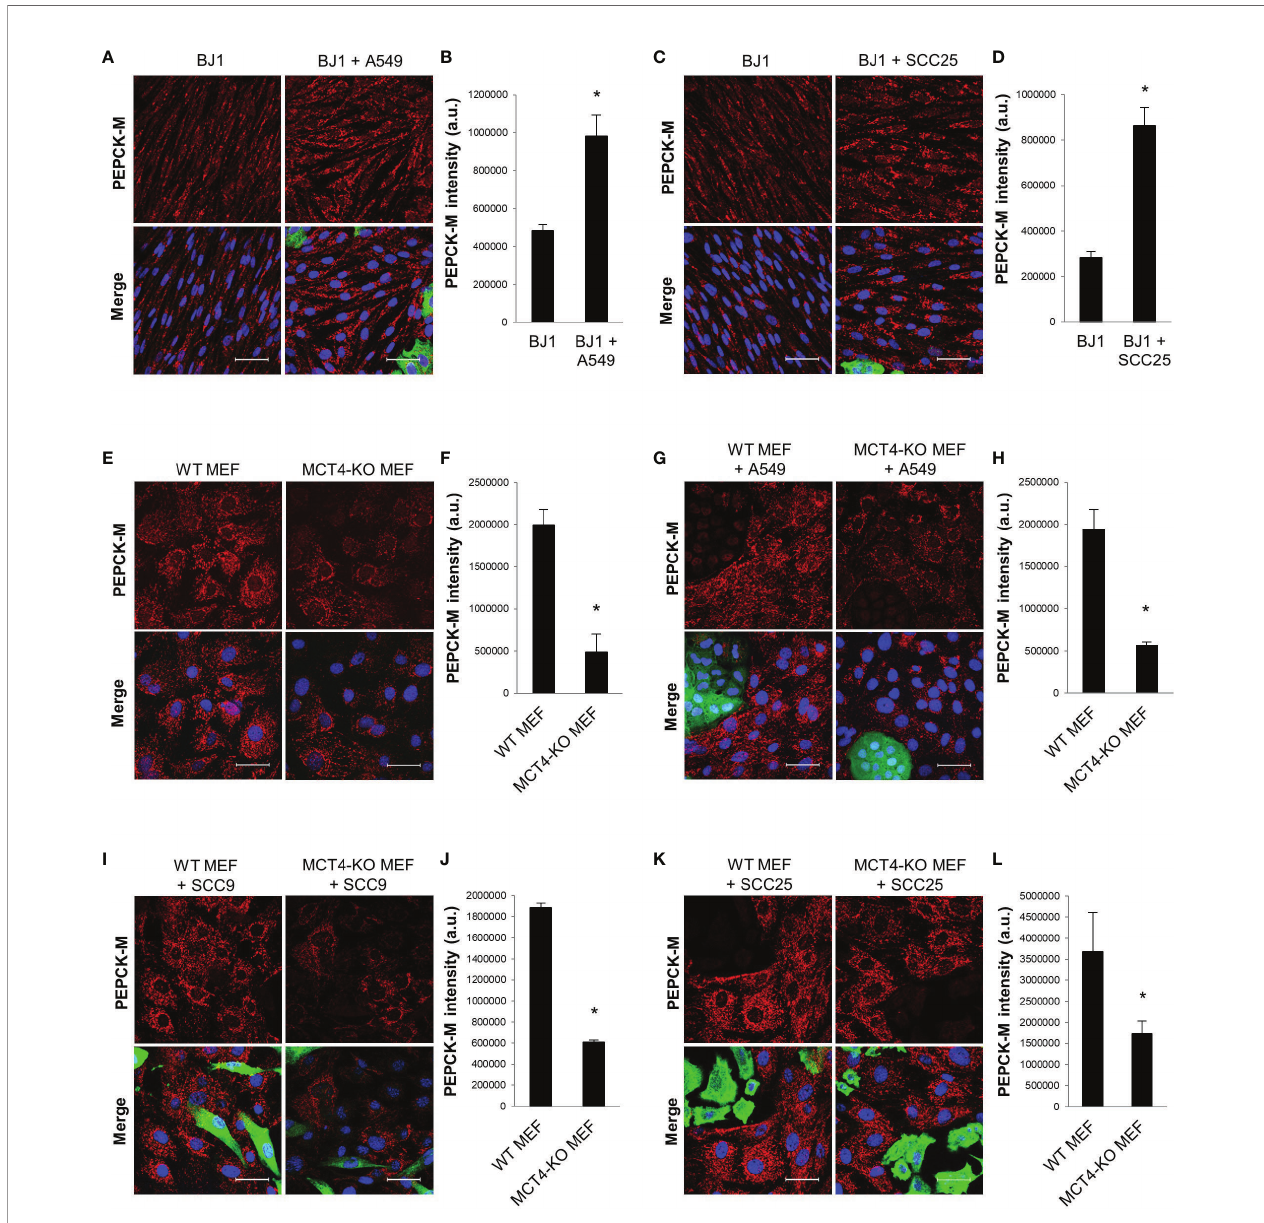
FIGURE 3 | PEPCK-M expression in glycolytic fi broblasts. BJ1 and WT or MCT4-KO MEF were co-cultured with ADT carcinoma cells. Monocultures of BJ1 and MEF were maintained in parallel as controls. (A – D) Confocal imaging of PEPCK-M in monocultures and in co-cultures of BJ1 with A549 (A) and SCC25 (C) , and their respective quanti fi cation of PEPCK-M staining in BJ1 (B, D) . (E, F) Confocal imaging of PEPCK-M in monocultures of WT and MCT4-KO MEF (E) and quanti fi cation of PEPCK-M staining (F) . (G – L) Confocal imaging of PEPCK-M in WT and MCT4-KO MEF in co-culture with A549 (G) , SCC9 (I) and SCC25 (K) , and their respective quanti fi cation of PEPCK-M staining in MEF (H, J, L) . Confocal microscopy images were acquired at the 40X magni fi cation. For all images, PEPCK-M staining is shown in red, carcinoma cells are shown in green (K8/18 staining), and nuclei are shown in blue (DAPI). PEPCK-M staining was quanti fi ed using ImageJ. Student ’ s t-test was used for statistical analyses (*p<0.05). (a.u., arbitrary units. Scale bar = 50 m